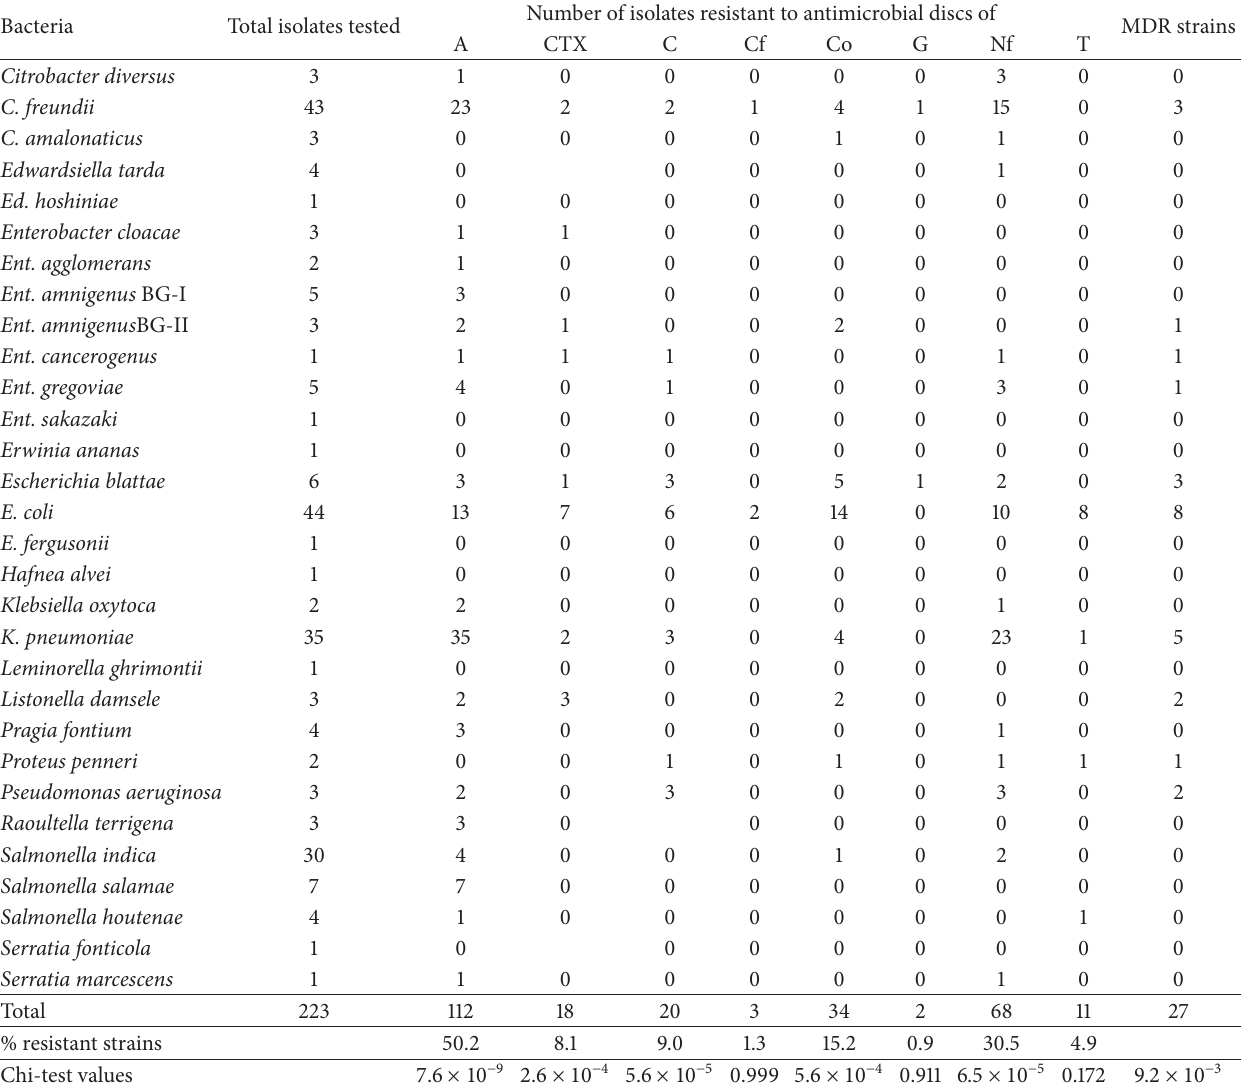
Table 2: Antimicrobial drug resistance of bacteria isolated from faecal droppings of geckos.